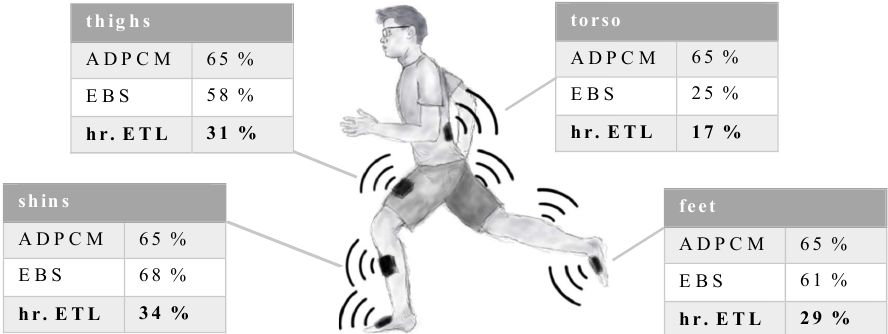
Figure 12. Total number D of transmitted bits including the Bluetooth 5 overhead with respect to full communication with D full bits. Three of the methods—adaptive differential pulse code modulation (ADPCM), event-based sampling (EBS), and hierarchical ETL—are considered for four different types of body segments during 4 min of variable gait. The values for feet, shins, and thighs are averaged (left and right body